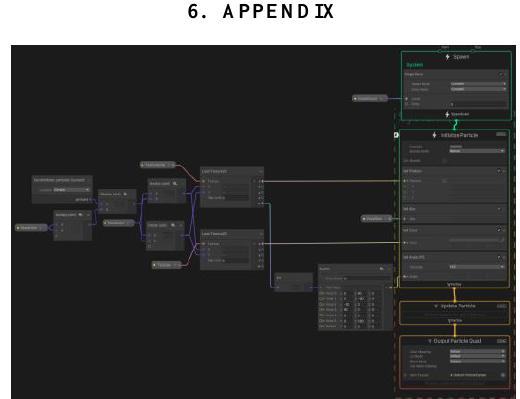
Figure 10 . VFX graph using quads for voxel visualisation